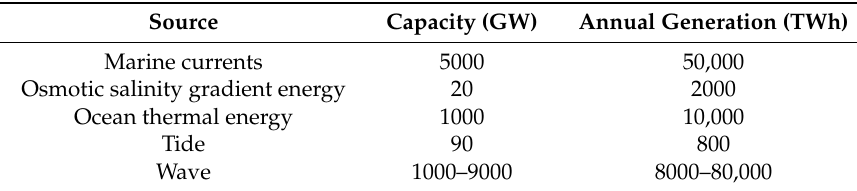
Table 1. Theoretical global ocean energy resources